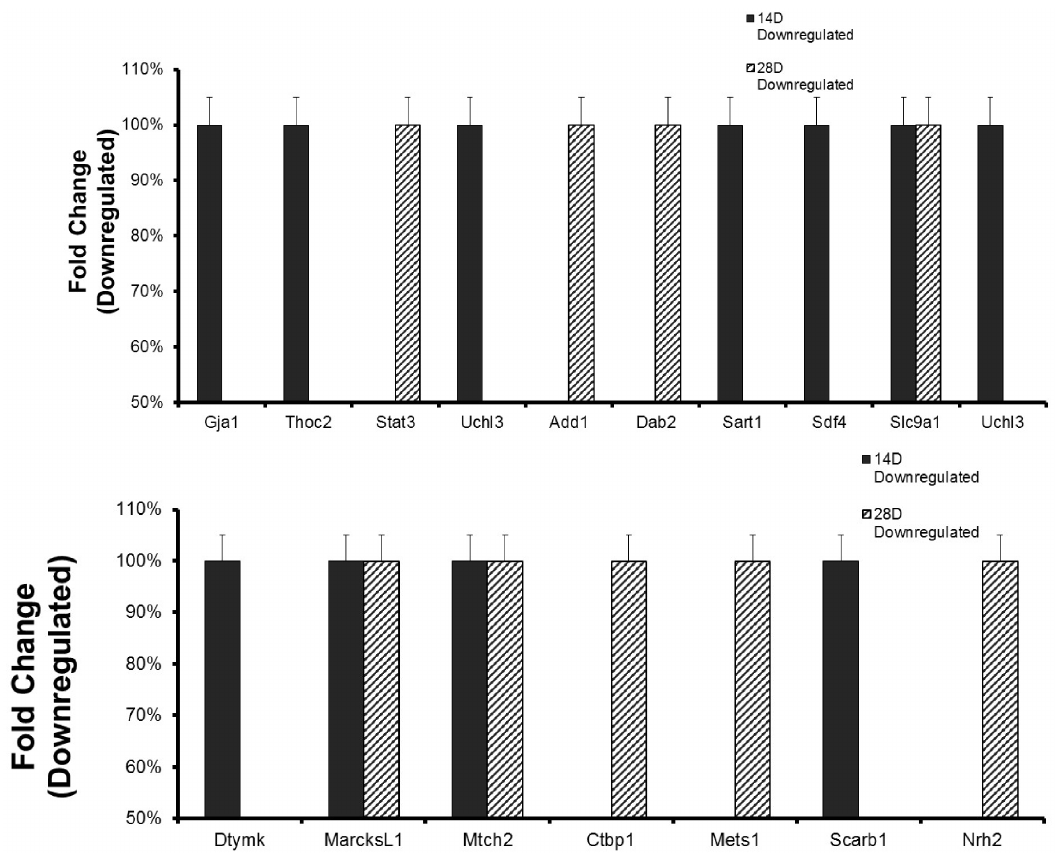
Fig 7. Chlamydia infection caused the altered expression of proteins that regulate epithelial functional integrity and pathologic EMT in the reproductive system (Down-regulation). Results were obtained as described in Fig 6 and selected molecules that were down-regulated have been